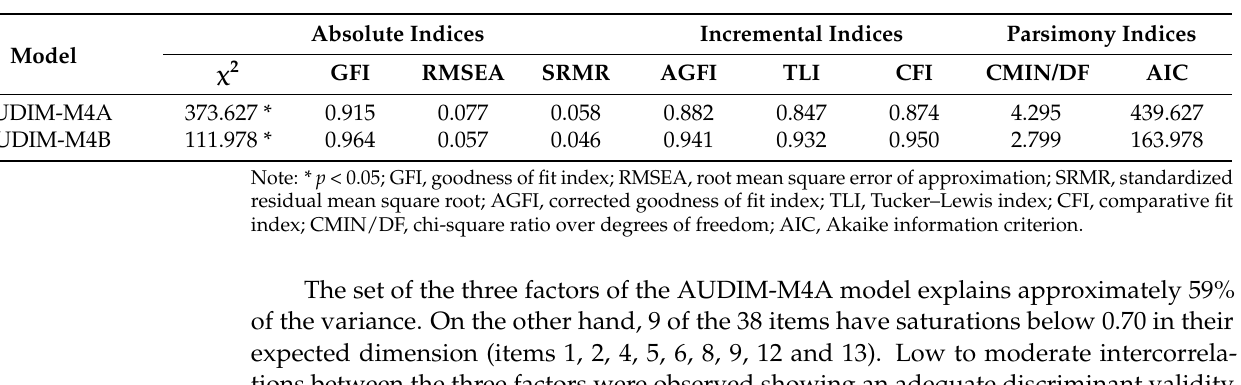
Table 1. Absolute, incremental and parsimony indices for the generated